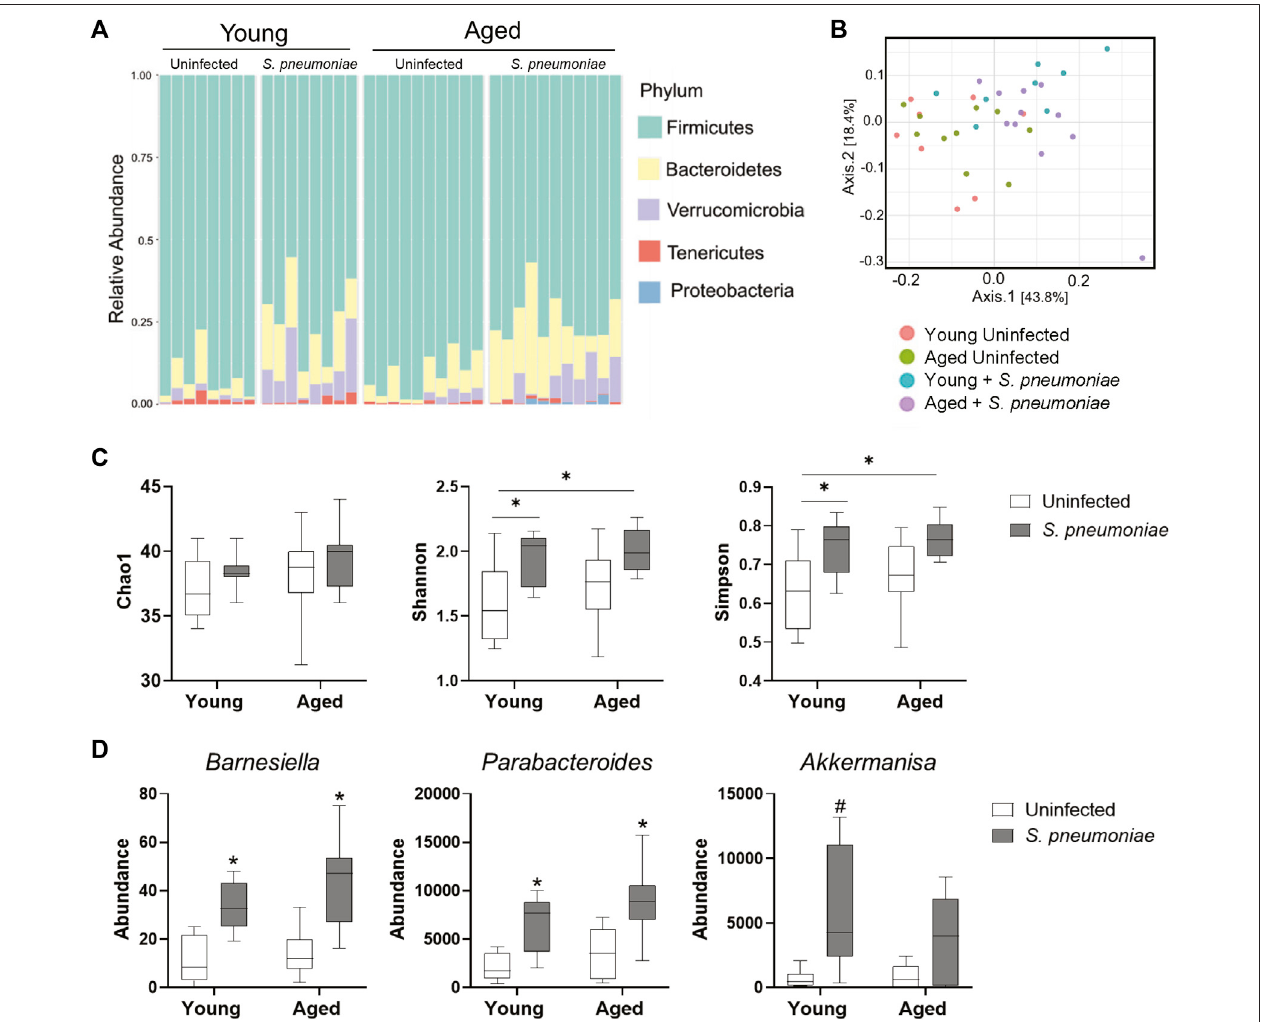
FIGURE 4 | S. pneumoniae infection is associated with alterations in the fecal microbiome in both young and aged mice. (A) Schematic representation of bacterial phyla in the fecal microbiota composition across young and aged mice pre- and post-infection with S. pneumoniae . Bars represent relative abundances of the 5 most abundant phyla for each individual mouse. (B) PCoA plot showing clustering of beta diversity of the fecal bacterial populations between the different treatment groups. (C) Measures of alpha-diversity within each fecal microbiome: richness (Chao1), evenness (Shannon) and diversity (Simpson). * p < 0.05 by ANOVA. (D) Results of Kruskal-Wallistestsofrelativeabundanceofspeci fi ctaxaacrossallfourtreatmentgroups.* p < 0.05comparedtobothyoungandageduninfected.# p < 0.05compared to young uninfected. n = 8 – 10 mice per groups.